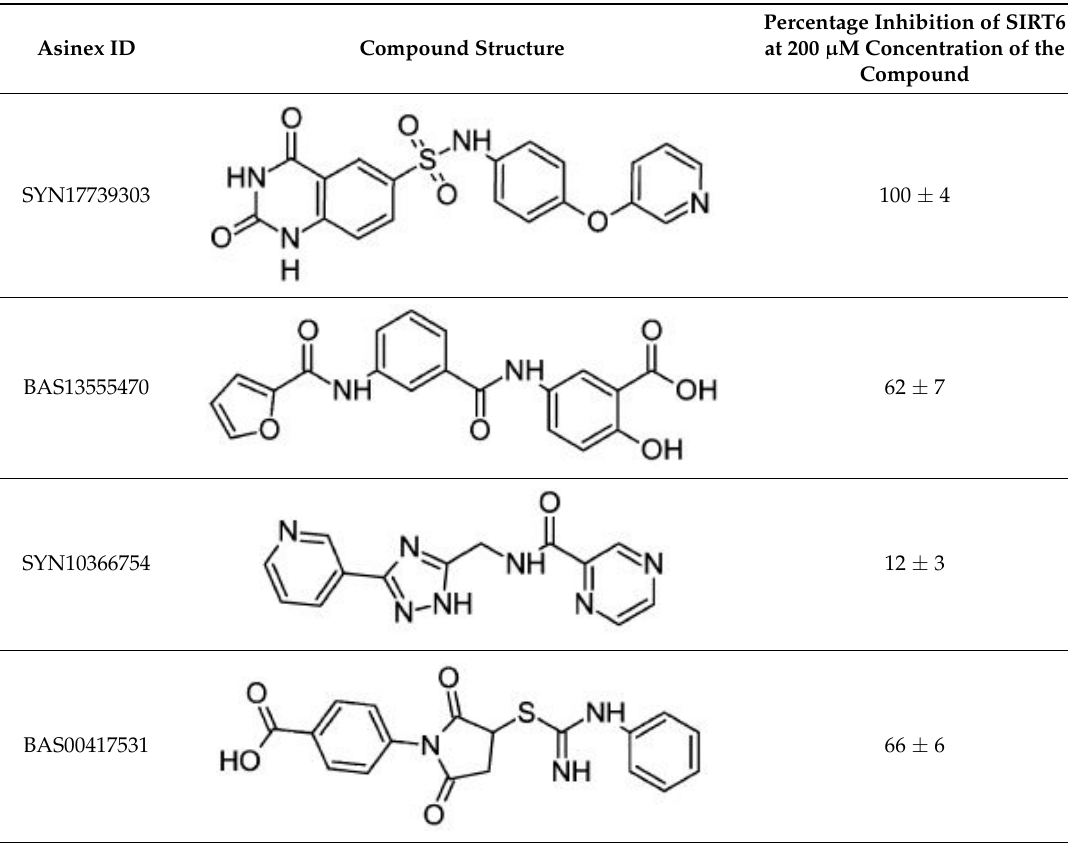
Table 2. Small molecule SIRT6 inhibitors (as reported by Parenti et al. [90]).